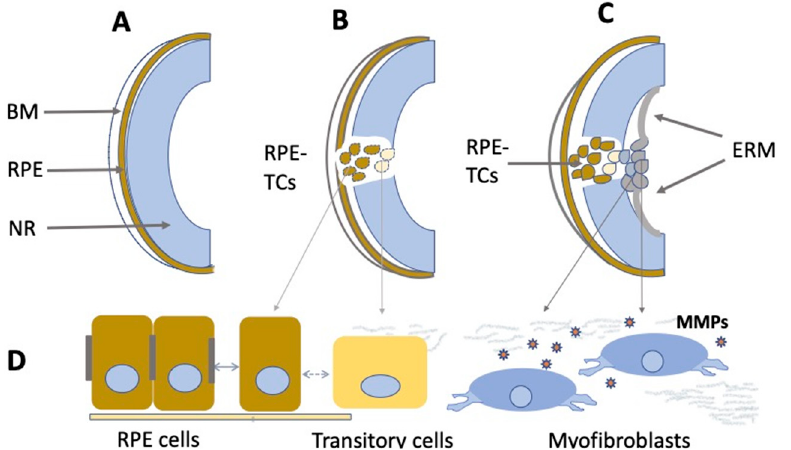
Figure 4. Schematic illustration of PVR development. ( A )—Normal eye. BM—Bruch’s membrane, RPE—retinal pigment epithelium, NR—neural retina. ( B )—RPE at the beginning of the epithelial– mesenchymal transition. RPE-TCs—RPE-derived transforming cells. ( C )—Epiretinal membrane (ERM) formation. ( D )—Morphological changes of RPE cells during the epithelial–mesenchymal transition. MMPs—Matrix metalloproteases.